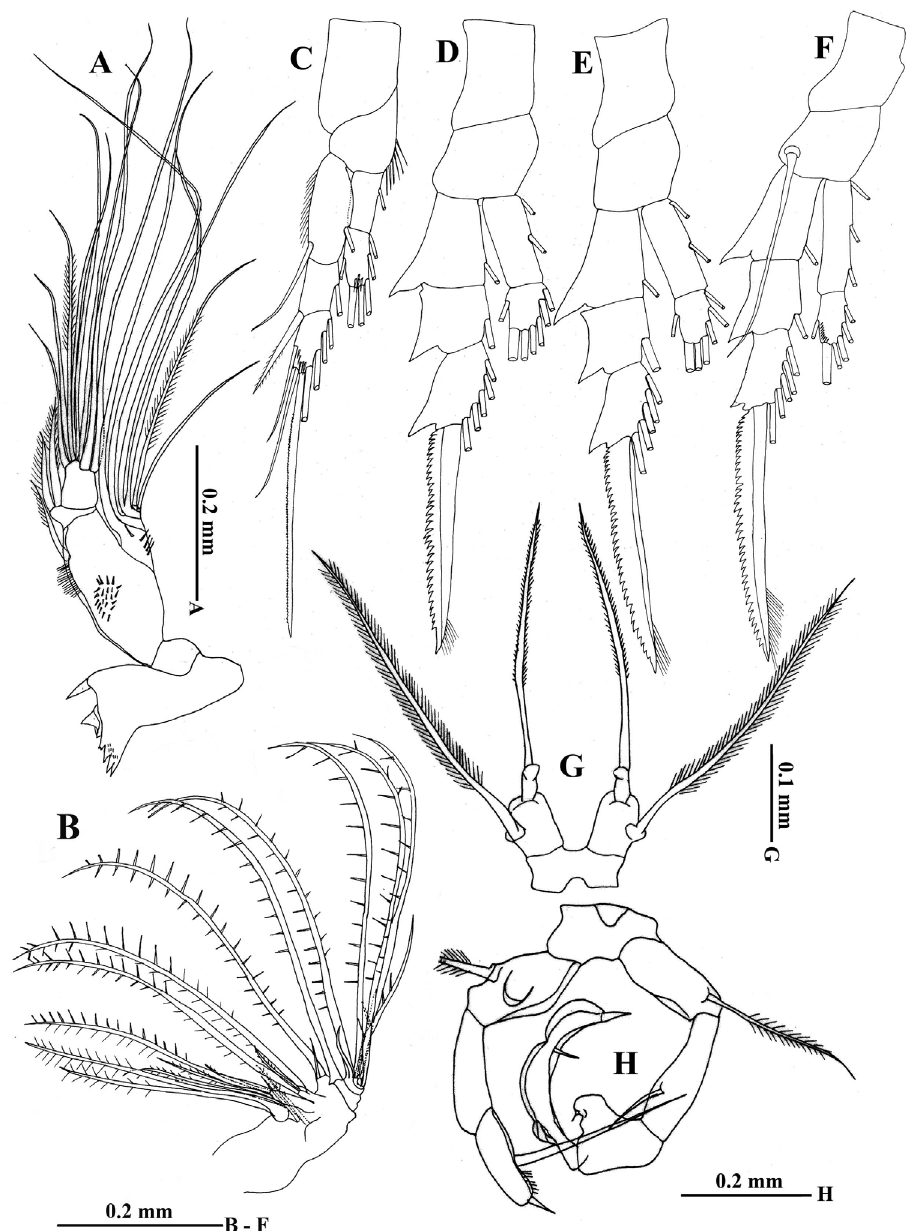
Figure 3. Acartia ( Odontacartia ) edentata sp. n. female ( A–G ) and male ( H ) (holotype) A Mandible